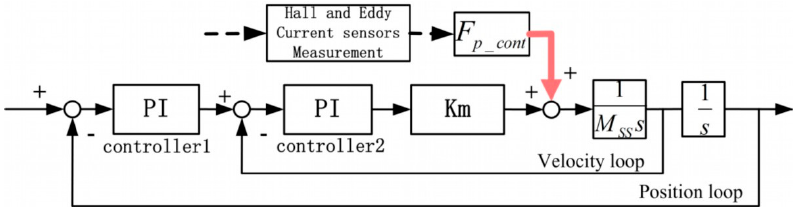
Figure 13. Force feedforward to compensate PDDFs.